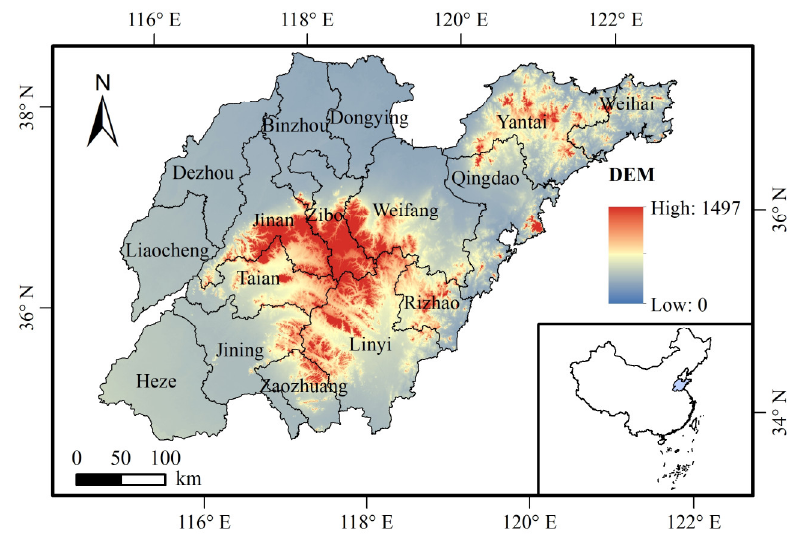
Figure 1. Study Figure 1. Study area.